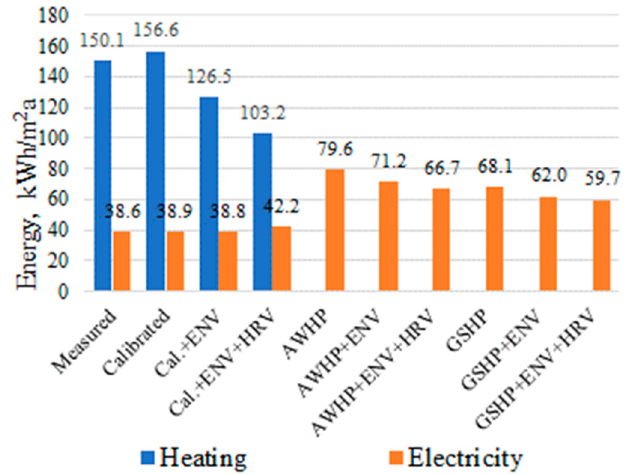
Figure 4. Delivered heating and electricity use of a reference single-family house in simulated renovation measures.